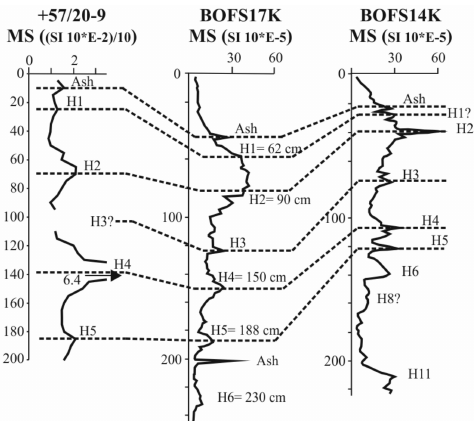
Figure 4. Comparison of MS between depth profiles from the three sites: + 57-20 / 9 core (this work), BOFS17K, and BOFS14K (modified from [20,30,49]). See Figure 1 for